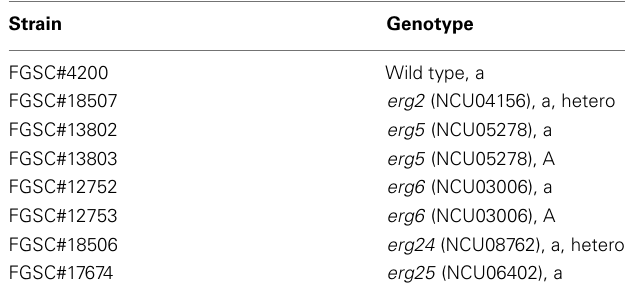
Table 1 | Neurospora strains used in this